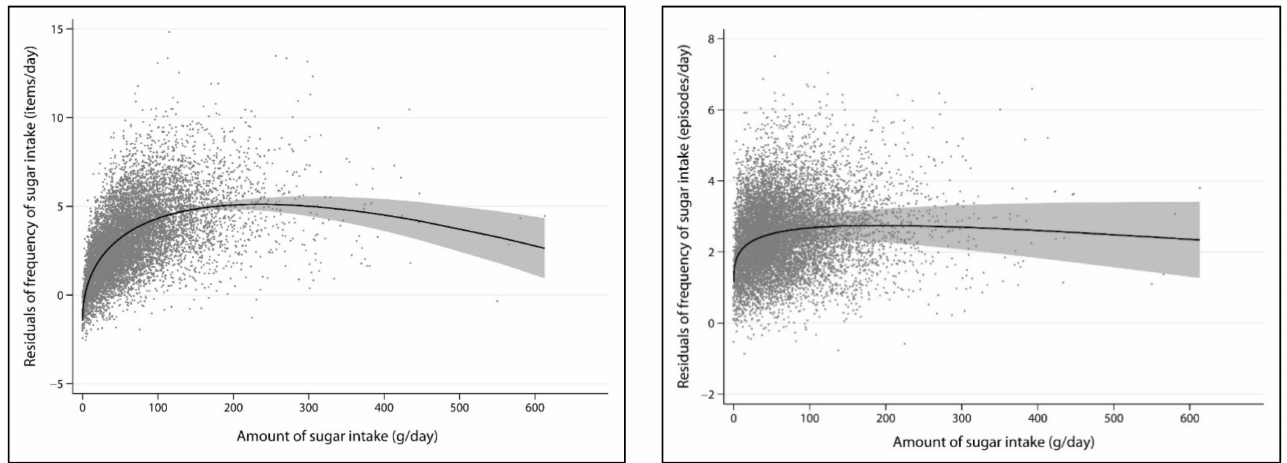
Figure 1. Graphical representation of the best-fitting fractional polynomials to characterize the relationship between the amount and frequency of added sugars intake. Predicted curves with 95% confidence intervals are reported along with the residuals. The frequency of added sugars intake in items/day is shown at the top (powers 0.5; 1) and in episodes/day at the bottom (powers 0.5; 0.5). Both the amount and frequency of added sugars intake were associated with the DMFS score after adjustment for confounders (Table 3). In the mutually adjusted model (Model 2A), a 1-SD increase in the amount of added sugars intake (=54.5 g/day) was associated with 1.11 (95% CI: 1.08–1.15) times greater DMFS score whereas a 1-SD increase in the frequency of added sugars intake (=2.3 items/day) was not associated with the DMFS score. In Model 2B, a 1-SD increase in the amount of added sugars intake was associated with 1.11 (95% CI: 1.07–1.15) times greater DMFS score whereas a 1-SD increase in the frequency of added sugars intake (=1.1 episodes/day) was associated with 1.05 (95%